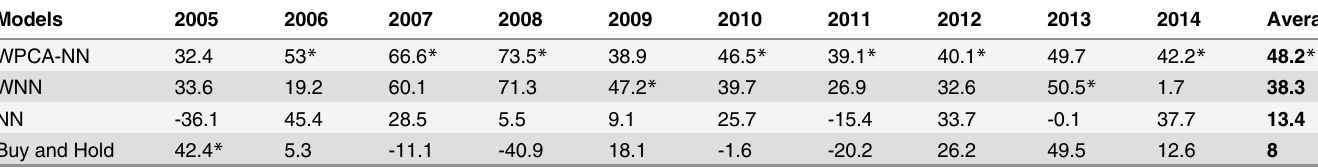
Table 8. Return of the models, results for NIKKEI 225 futures. Models